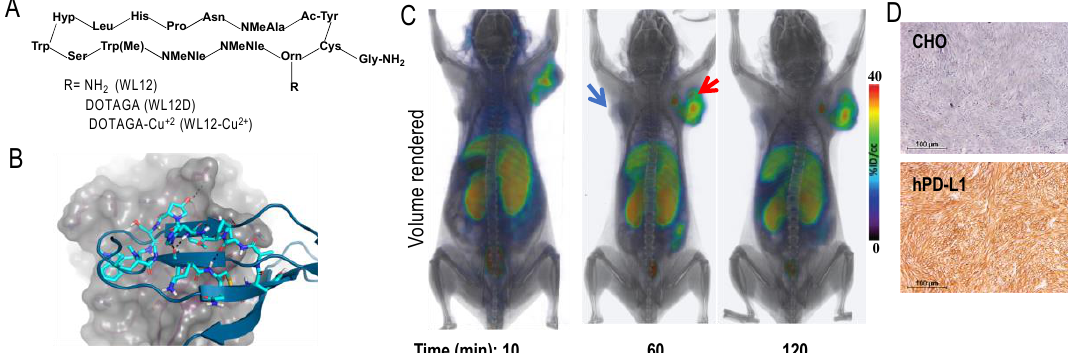
Figure 1. WL12 binding interactions with PD-L1 overlap with those of PD-1. ( A ) Structural representation of WL12 and its analogs; ( B ) predicted binding mode of WL12 to PD-L1. WL12 forms a beta sheet-like structure in the groove of PD-L1. WL12 is shown in cyan. The surface representation of PD-L1 is shown in gray, with the ribbons and key side chains shown in magenta; WL12 mimics PD-1 binding to PD-L1. The structure of PD-1 is shown in teal. The two main interacting beta strands of PD-1 overlap well with the conformation adopted by WL12 bound to PD-L1. ( C ) NSG mice with hPD-L1 (red arrow) and CHO tumors (blue arrow) were administered intravenously with 150 µ Ci of [ 64 Cu]WL12 and images were acquired at 10, 60, and 120 min after the injection of the radiotracer. 3D volume rendered images show specific accumulation of [ 64 Cu]WL12 in hPD-L1 tumors. ( D ) PD-L1 IHC shows strong immunoreactivity (brown color) in hPD-L1 tumors (from [153]).